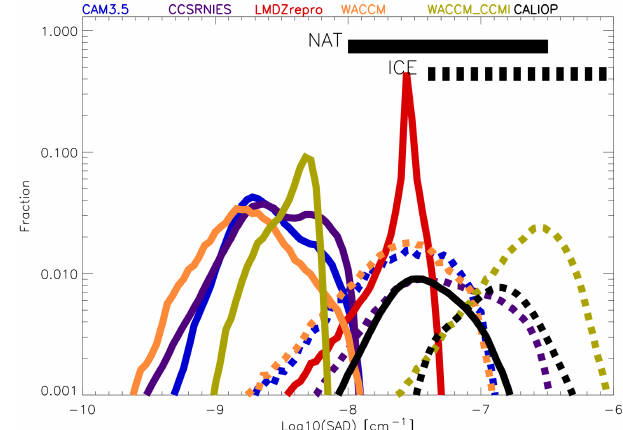
Figure 11. Histogram of the NAT (solid lines) and ice (dashed lines) SADs for some CCMVal models and for CALIOP (2006–2010) are displayed. The histograms for the model data have been truncated and represent 93% of the total SAD. The straight lines at the top of the figure indicate the range of SAD values for NAT and ice “ob- served” by ground-based lidars and are taken from Adriani et al.